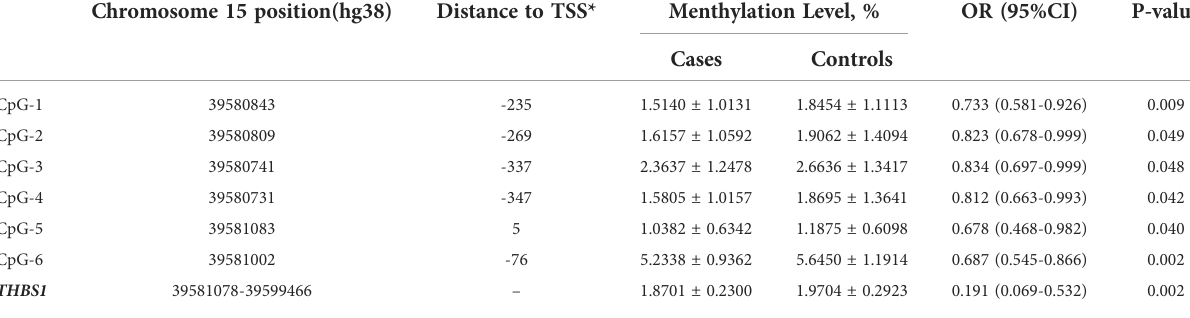
FIGURE 1 Location of the two CpG islands in THBS1 gene.